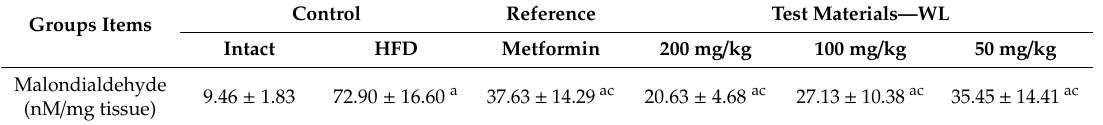
Table 13. Changes in the liver lipid peroxidation in NFD or HFD supplied mice. Groups Items